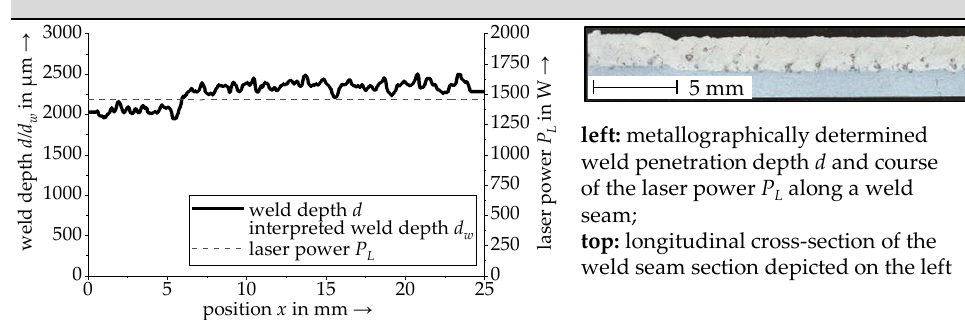
top: longitudinal cross-section of the weld seam section depicted on the left